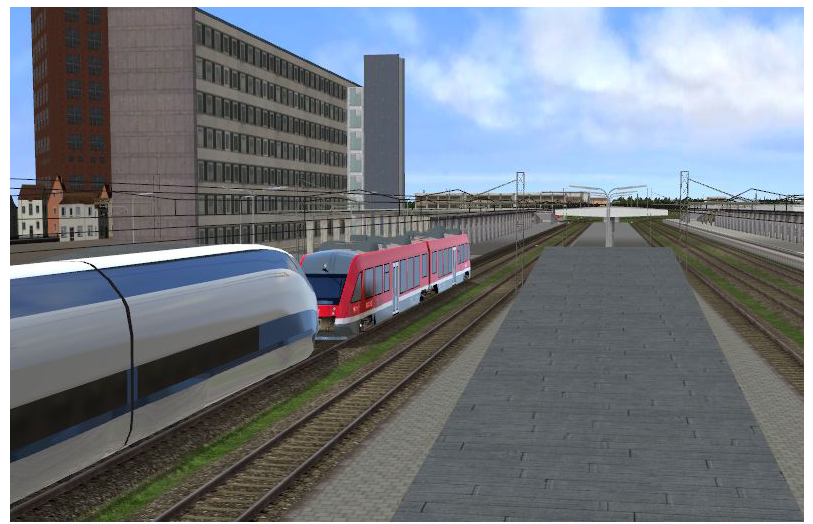
Figure 3: Example of the visualized track simulation.